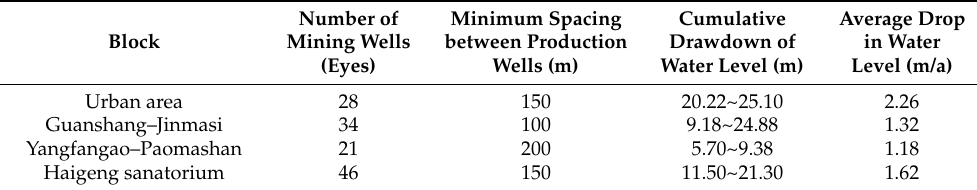
Table 6. Groundwater exploitation status of each